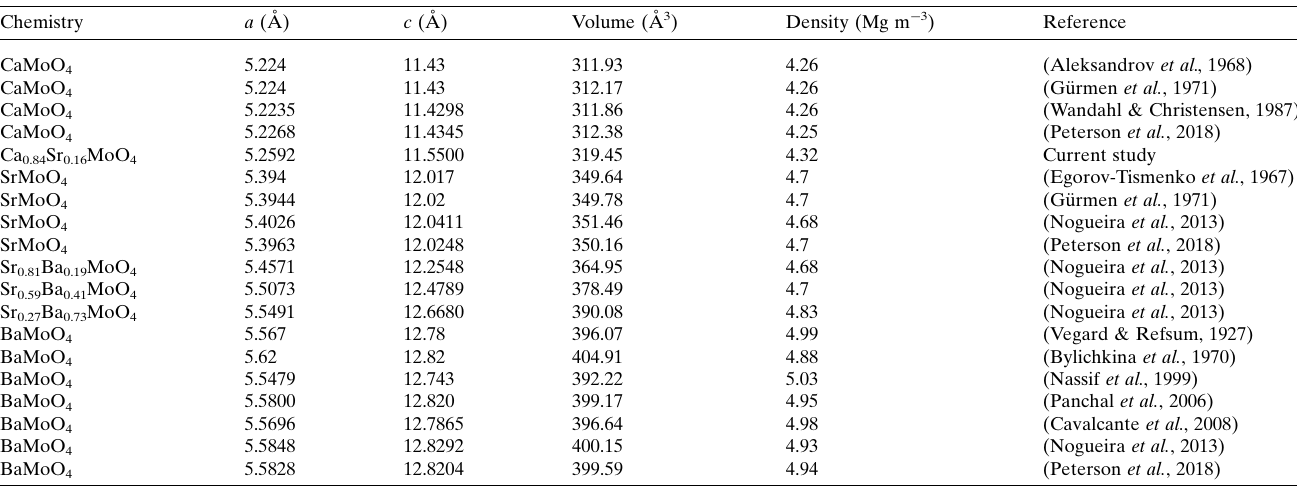
Table 1 Summary of data on (Ca, Sr, Ba)MoO 4 crystals from the literature and current study. Densities are calculated from crystallographic